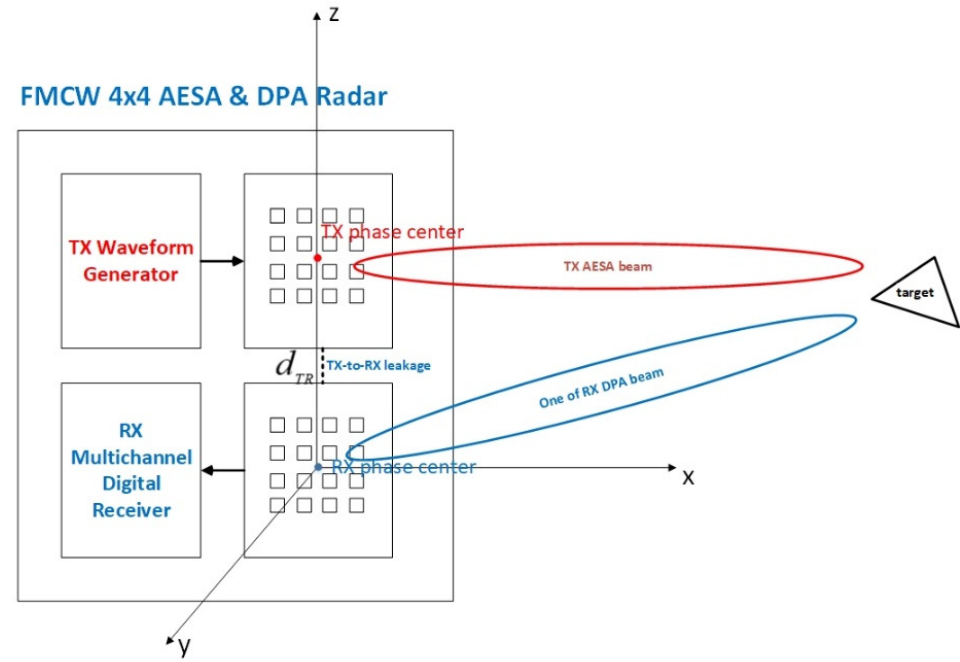
Figure 1. The active electronically scanned array (AESA) transmitter and the digital phased array (DPA) receiver with separate transmitter (TX) and receiver (RX) antenna panels. Both the TX and RX antenna panels have four-by-four element phase arrays. The RX and TX antenna phase centers are plotted as blue and red dots, respectively. The distance between the TX and the RX phase centers is d TR . The origin of the radar coordinate system is located at the RX phase center.